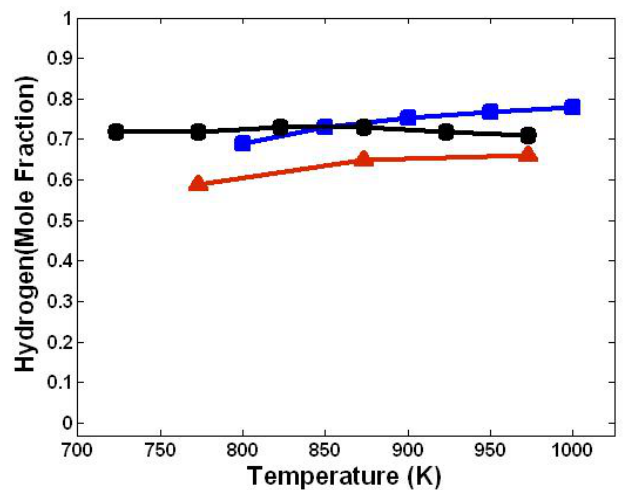
Figure 9. Effect of temperature on hydrogen production. This Model ( ■ ), Mahishi and Goswami [9] ( ▲ ), Florin and Harris [18] ( ●